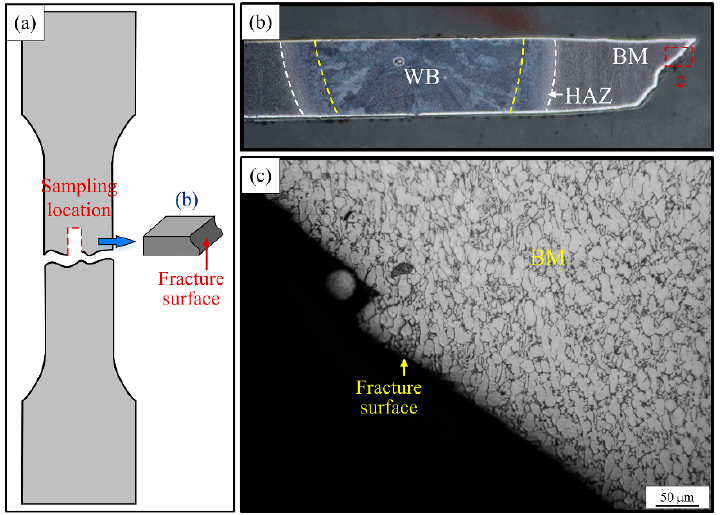
Figure 13. Macroscopic morphology and microstructure of the tensile specimen cross-section at failure position: ( a ) the schematic diagram of metallographic sampling location, ( b ) the macroscopic appearance of the cross section of the failure location, ( c ) the microstructure morphology.